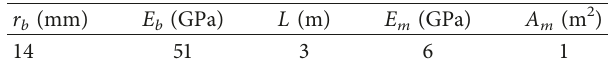
Table 1: Mechanical properties of the bolt and the confining medium used in this model.